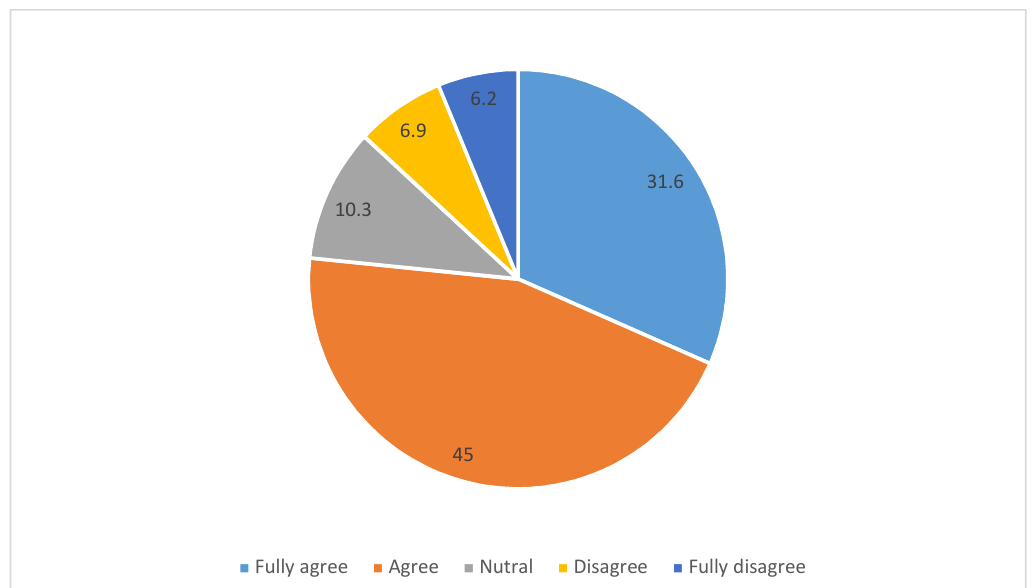
Fig. 3. The percentage of accounting human resources for “Monthly salary is commensurate with the responsibility and quality of